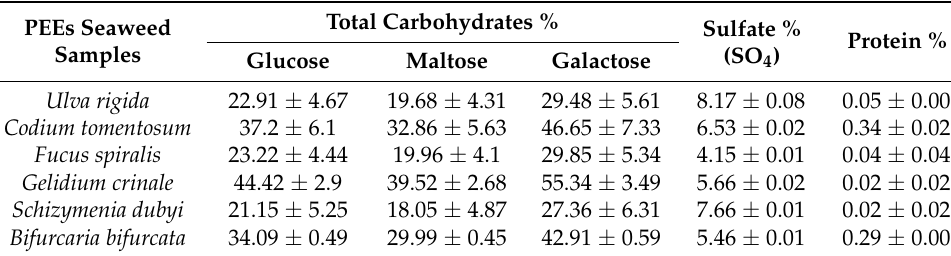
Table 3. Chemical composition of the six seaweed species polysaccharide-enriched extracts (PEEs). Total Carbohydrates PEEs Seaweed Samples